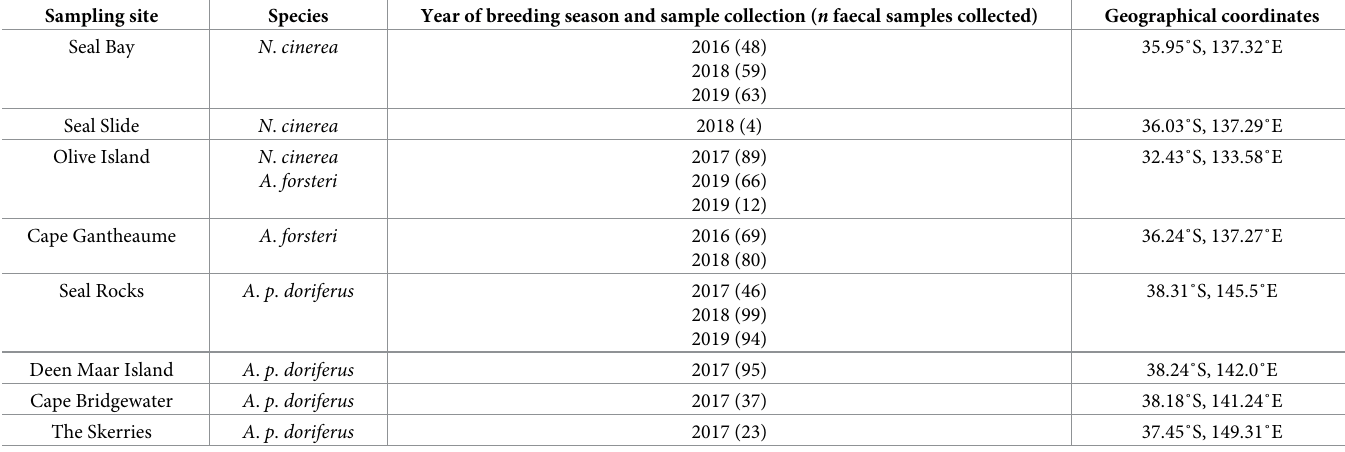
Table 1. Sample collection across breeding colonies and